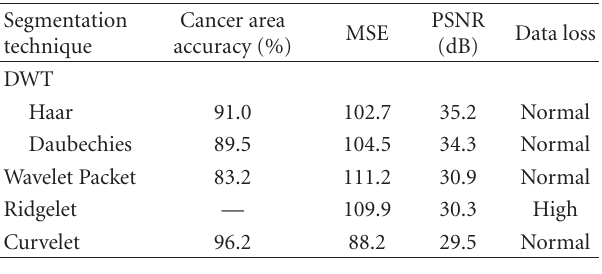
Table 5: Segmentation techniques’ performance based on patient data (kidney cancer data).